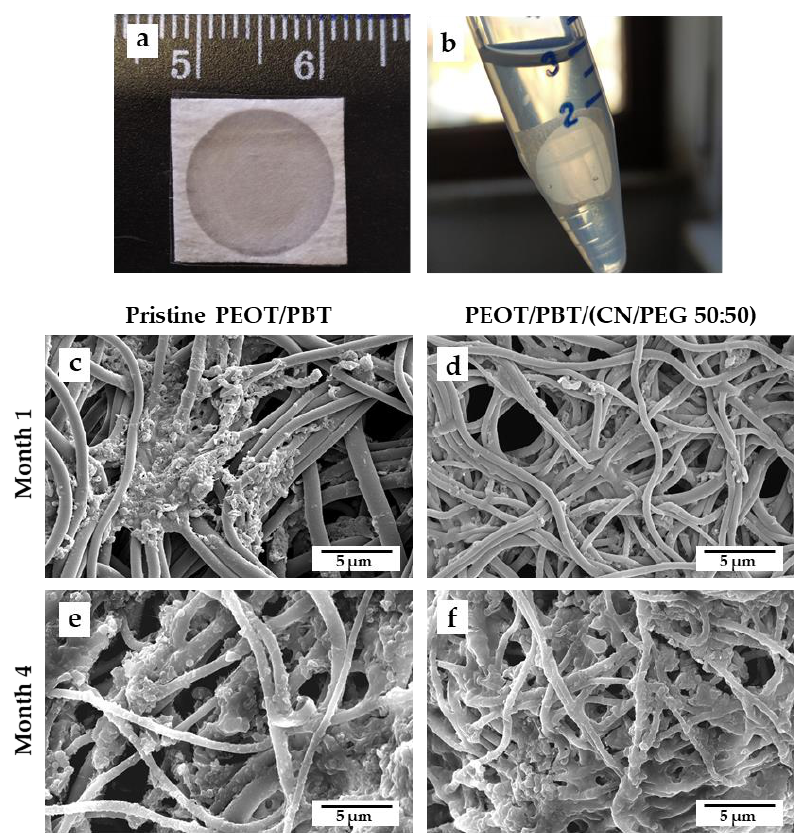
Figure 4. Degradation test of PEOT/PBT and PEOT/PBT/(CN/PEG 50:50) in an otitis-simulating fluid: ( a , b ) real size TM scaffold placed in the fluid at month 0; ( c − f ) SEM micrographs showing the fiber morphology of ( c , e ) PEOT/PBT, and ( d , f ) PEOT/PBT/(CN/PEG 50:50) meshes after ( c , d ) 1 month, and ( e , f ) 4 month incubation in the fluid. Scale bar: 5 μm, high voltage (HV) 10 kV, magnification 16,000 ×